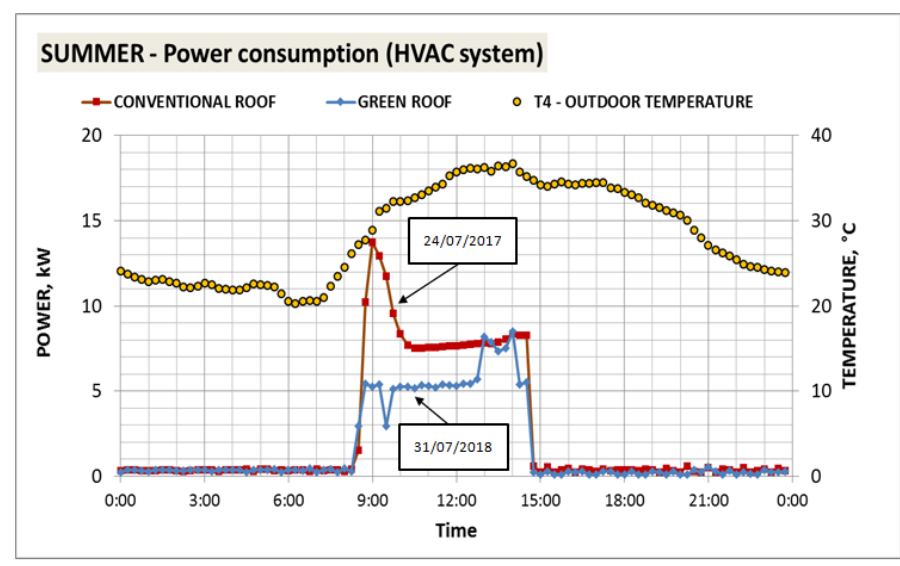
Figure 11. Comparison of similar days with and without a green roof in the summer period.